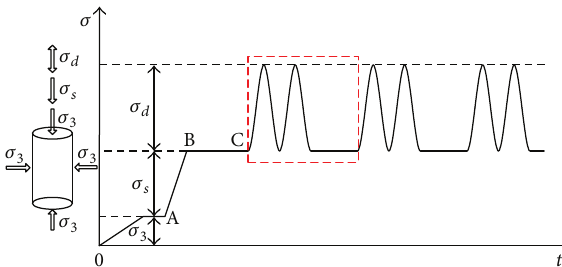
Figure 4: Cyclic stress loading pattern during repeated load triaxial